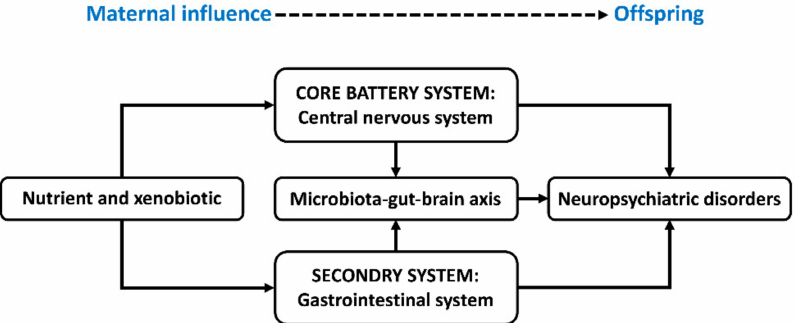
Figure 1. Schematic diagram illustrating the maternal metabolic fluctuations reprogramming neu- ropsychiatric development in offspring. Nutrients and xenobiotics may deposit in the fetal central nervous system and gastrointestinal system and consequentially reprogram the development and activity of the microbiota–gut–brain axis. These alterations act alone and integrally with potential to cause neuropsychiatric disorders in offspring. The central nervous system and gastrointestinal system have been recognized as the core battery system and secondary system by the International Council on Harmonization guideline S5 (R2) for safety assessment in maternal–fetal medicine